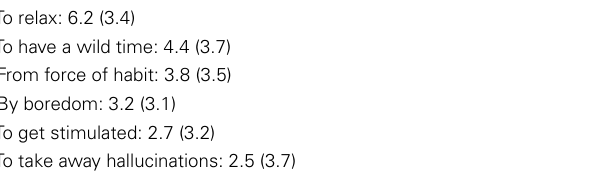
Table 4 | Motives of cannabis consumption (mean scores and SD)